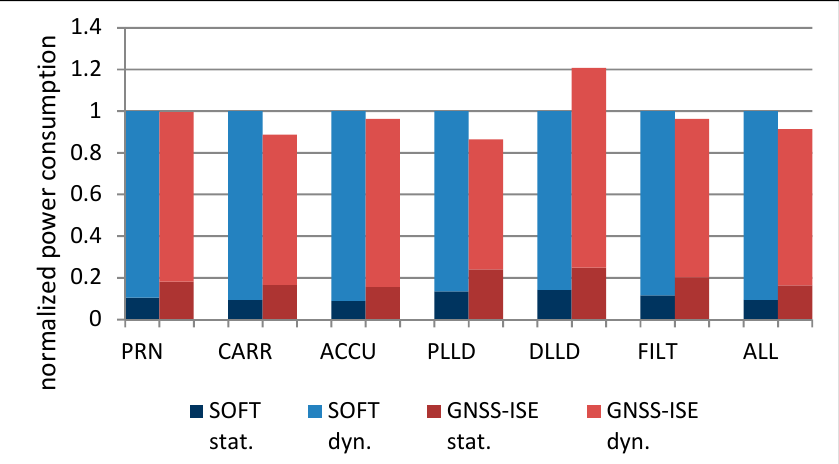
Figure 11. Normalized execution time of tracking loop tasks with GNSS-ISE and without GNSS-ISE.